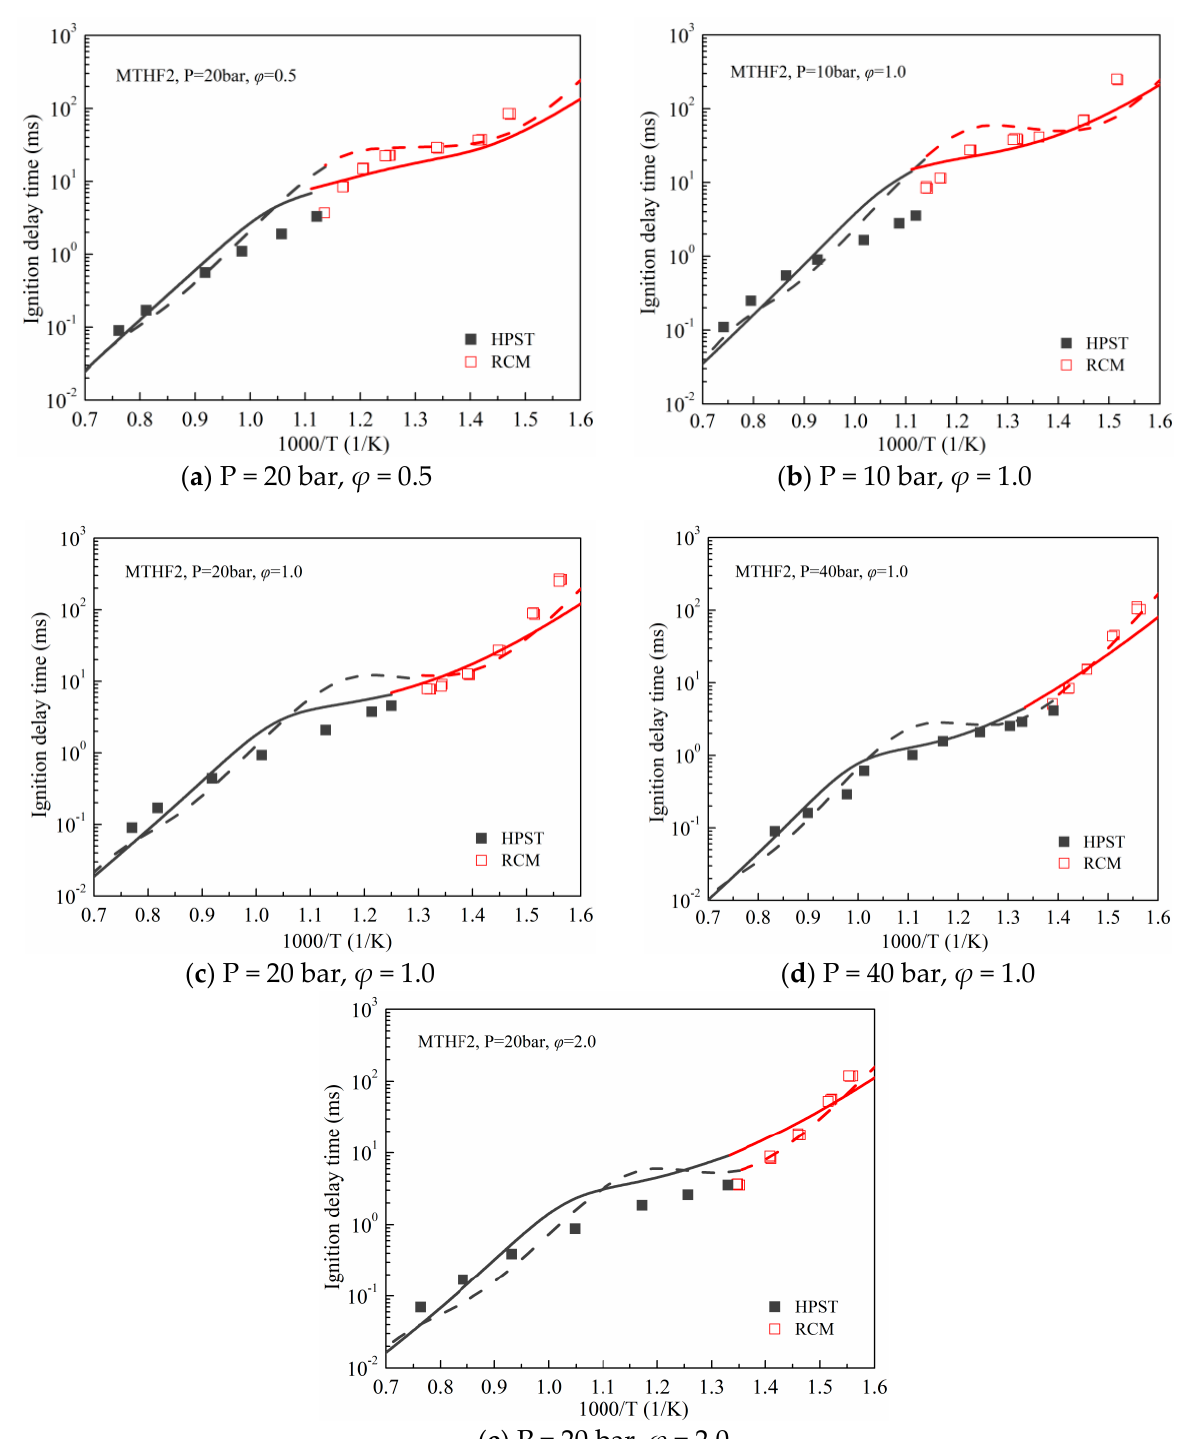
Figure 7. Measured (symbols) [17] and calculated (lines) ignition delay times for MTHF2. Solid lines: reduced diesel/MTHF2 mechanism; dashed lines: detailed MTHF2 mechanism [17].